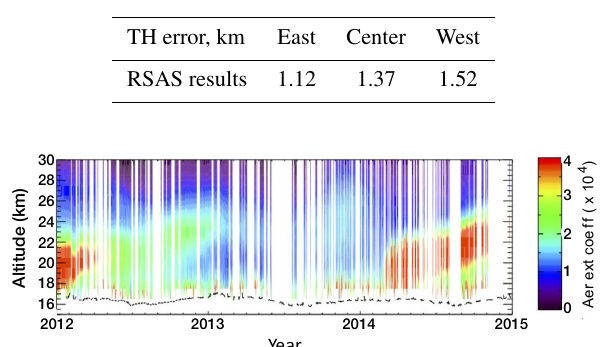
Table 1. RSAS results at the Equator before the Kelud eruption in February 2014. The time period had a minimum aerosol loading (during OMPS lifetime) and was chosen using OSIRIS measure- ments (Fig. 8).